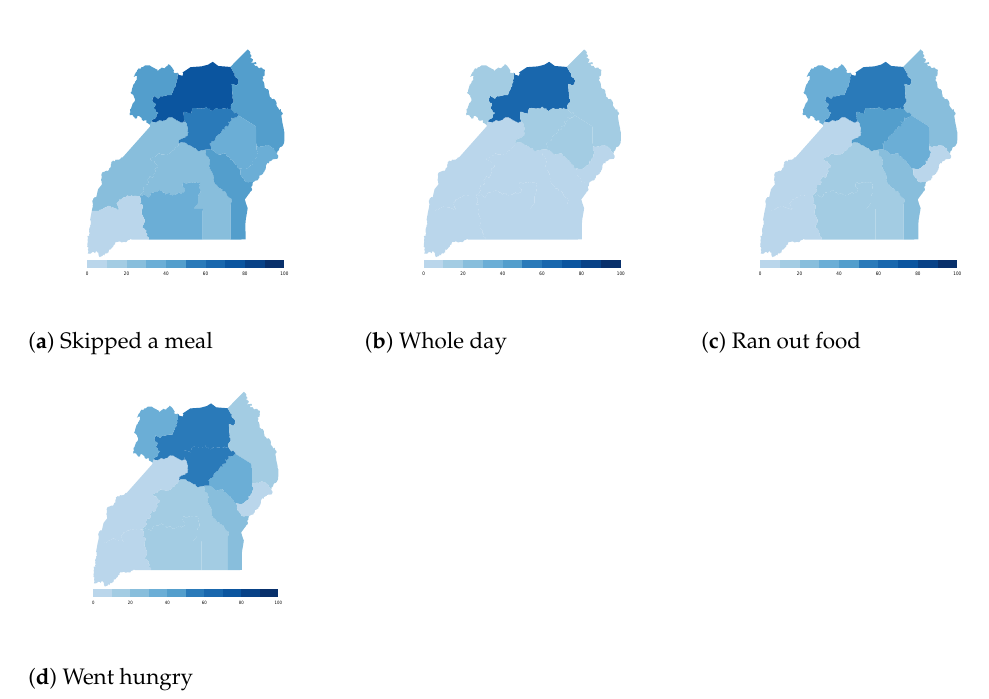
Figure 11. Uganda—share of